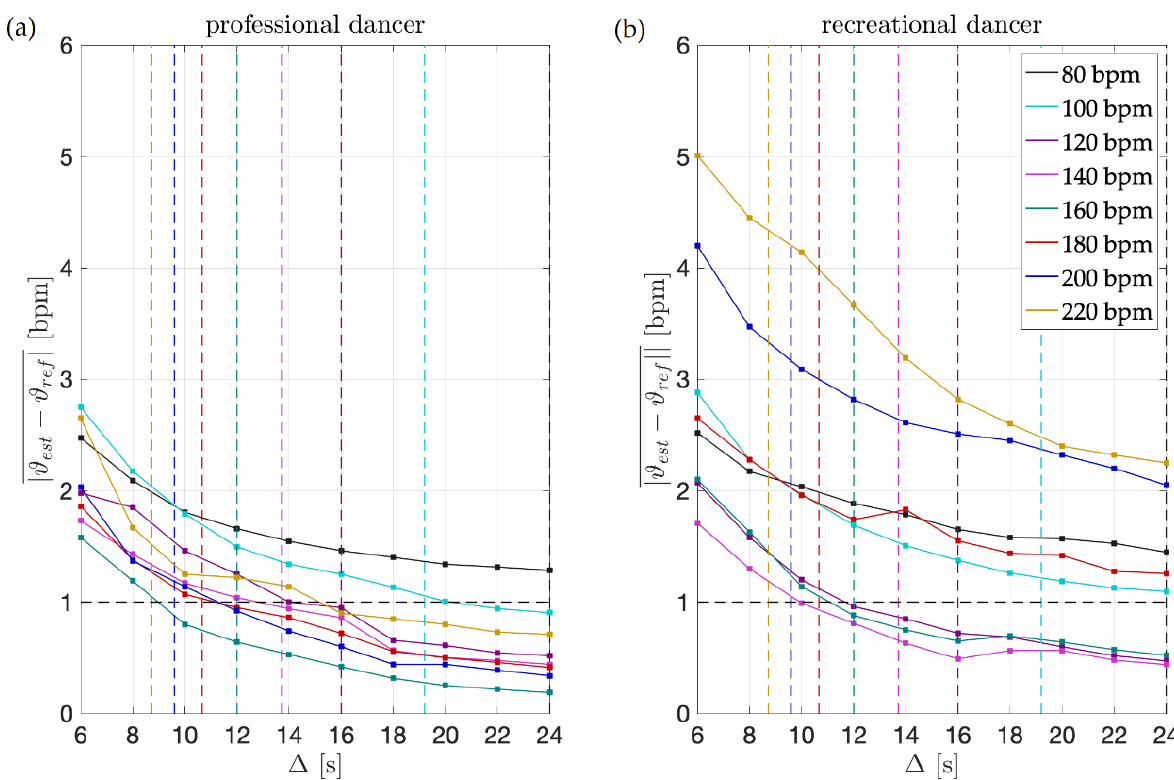
Figure 4. Dance tempo estimation results for short dance excerpts. Each vertical, colored line additionally illustrates the duration of four consecutive dance moves, for each dance tempo respectively. For ( a ) the professional dancer for excerpts of such duration, the results are at the level of 1 bpm accuracy for all tempos. For ( b ) the recreational dancer, this holds only for the intermediate tempos, i.e., 100, 120, 140, and 160 bpm.